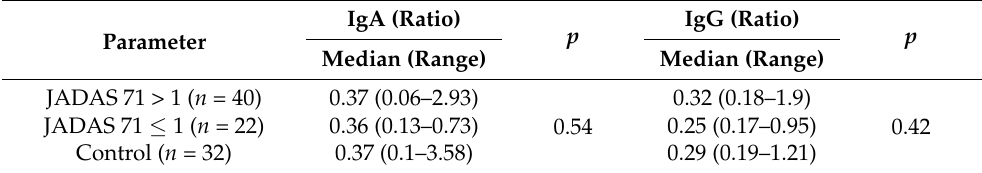
Table 5. Anti-SARS-CoV-2 levels in JIA patients depending on disease activity (JADAS